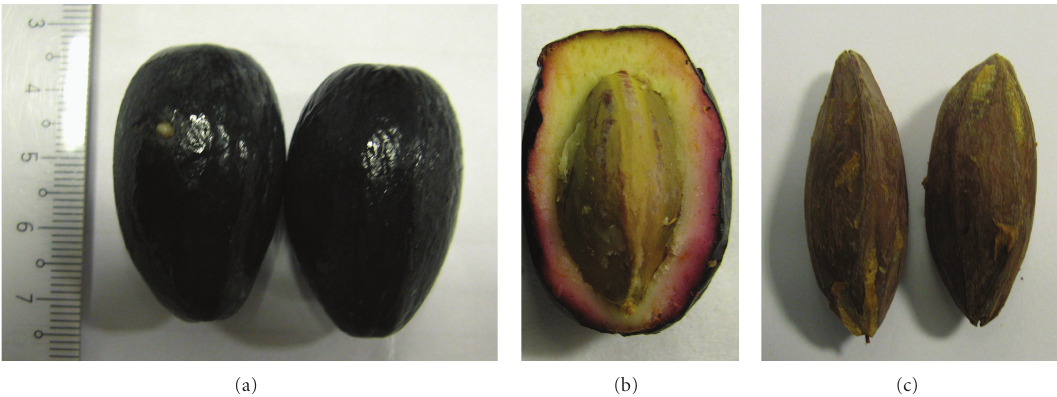
Figure 1: Fruits of Canarium odontophyllum (a), pulp (b), and seed (c). Unit of measurement is in cm.